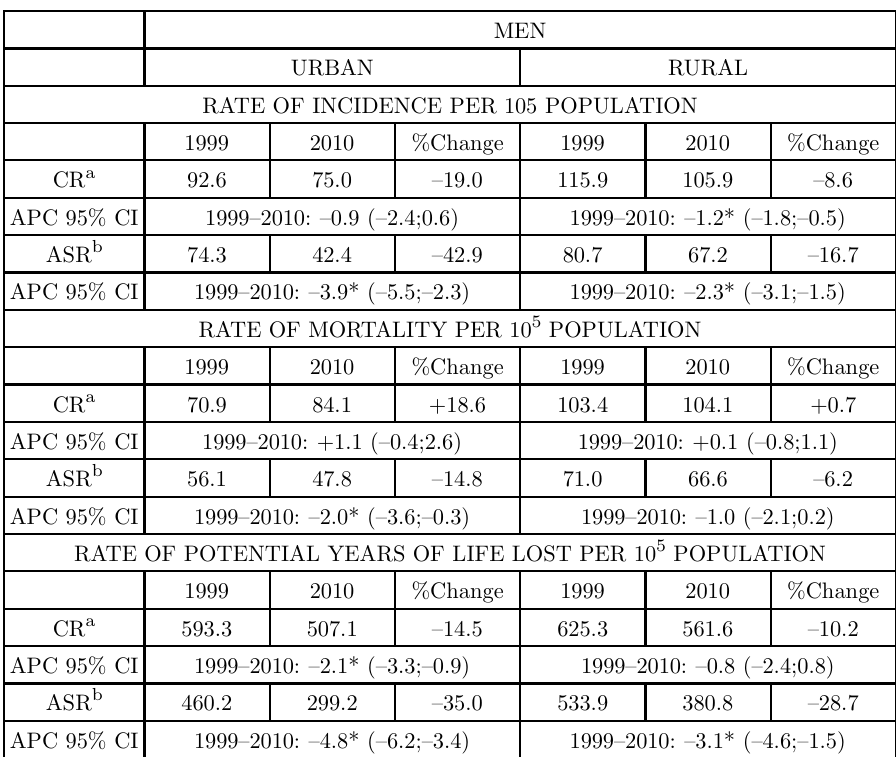
Table 1. Rates of incidence, mortality, and PYLL of lung cancer and their trends from 1999–2010 in the urban and rural areas in the Święto- krzyskie Province